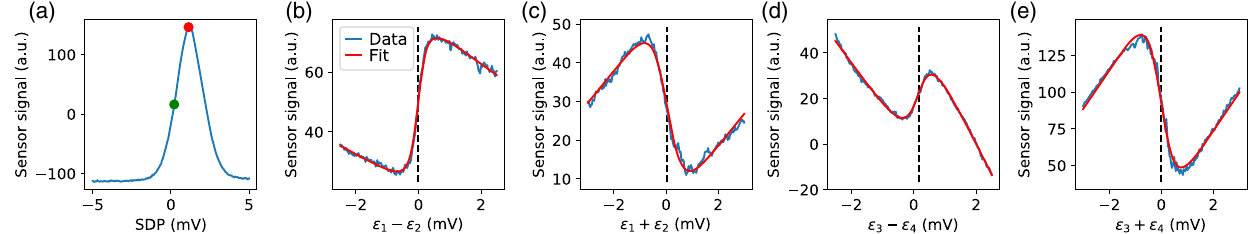
FIG. 11. Automatic calibration of pulse voltage offsets. (a) Sensing dot calibration, with the red marker corresponding to the top of the Coulomb peak, and the green marker is the half-height on the rising flank, (b) interdot transition between (0202) and (1102), (c) dot- reservoir transition between (0202) and (1202), (d) interdot transition between (0202) and (0211), (e) dot-reservoir transition between (0202) and (0212). The traces are not centered at the same voltages, but voltage offsets are added for each scan based on the previous